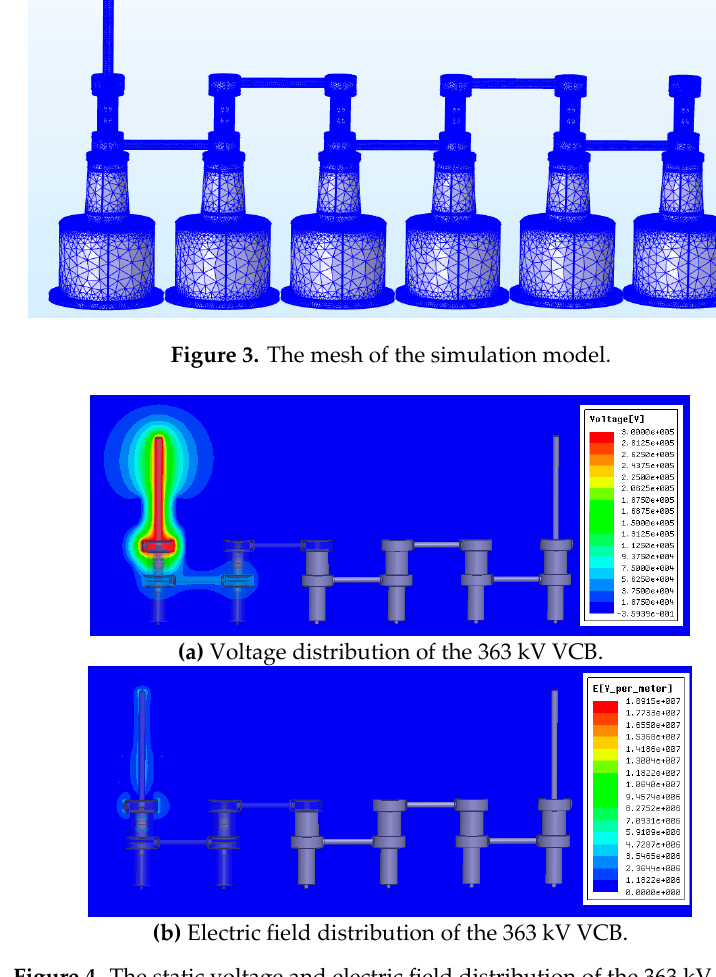
Figure 4. The static voltage and electric field distribution of the 363 kV VCB.